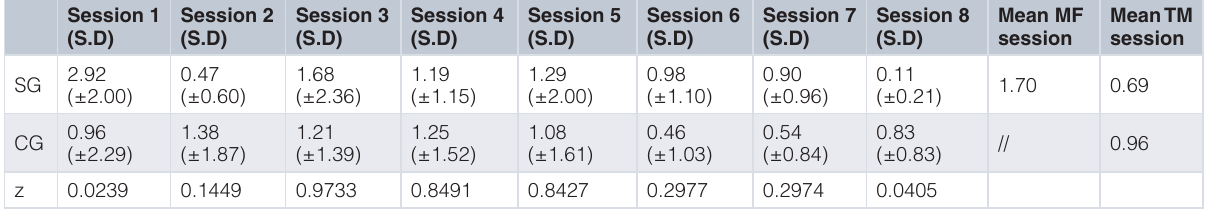
Table 4. Mean VAS variation for each treatment session, mean difference between CG and SG S.D.= standar